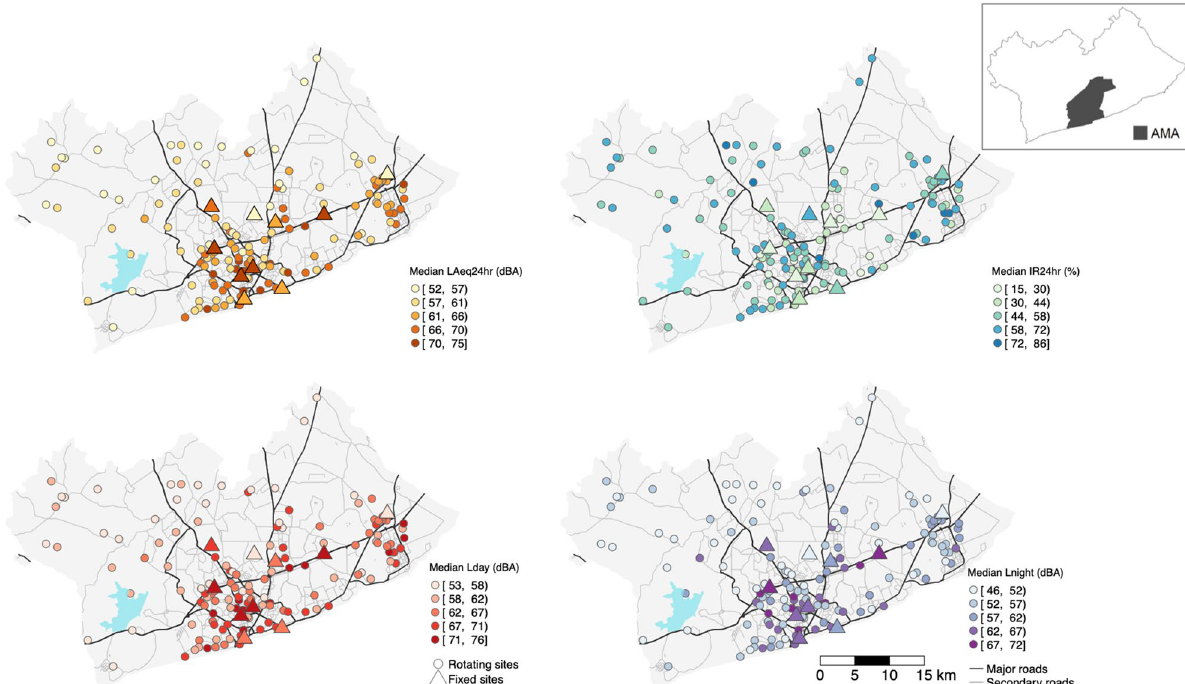
Figure 1. Median sound level and intermittency metrics for rotating and fixed site locations in the GAMA. For the color legend scales, a bracket means that the value in the range is included and a parenthesis means that the value in the range is not included. Road network is from OpenStreetMap and the Greater Accra Metropolitan Area (GAMA) and Accra Metropolitan Area (AMA) boundary from Ghana Statistical Service. A waterbody is depicted on the map in light blue. LAeq 24hr : A-weighted equivalent continuous 24-h sound level; L day and L night : A-weighted equivalent continuous sound level in the day and night-time; IR 24hr : 24-h Intermittency